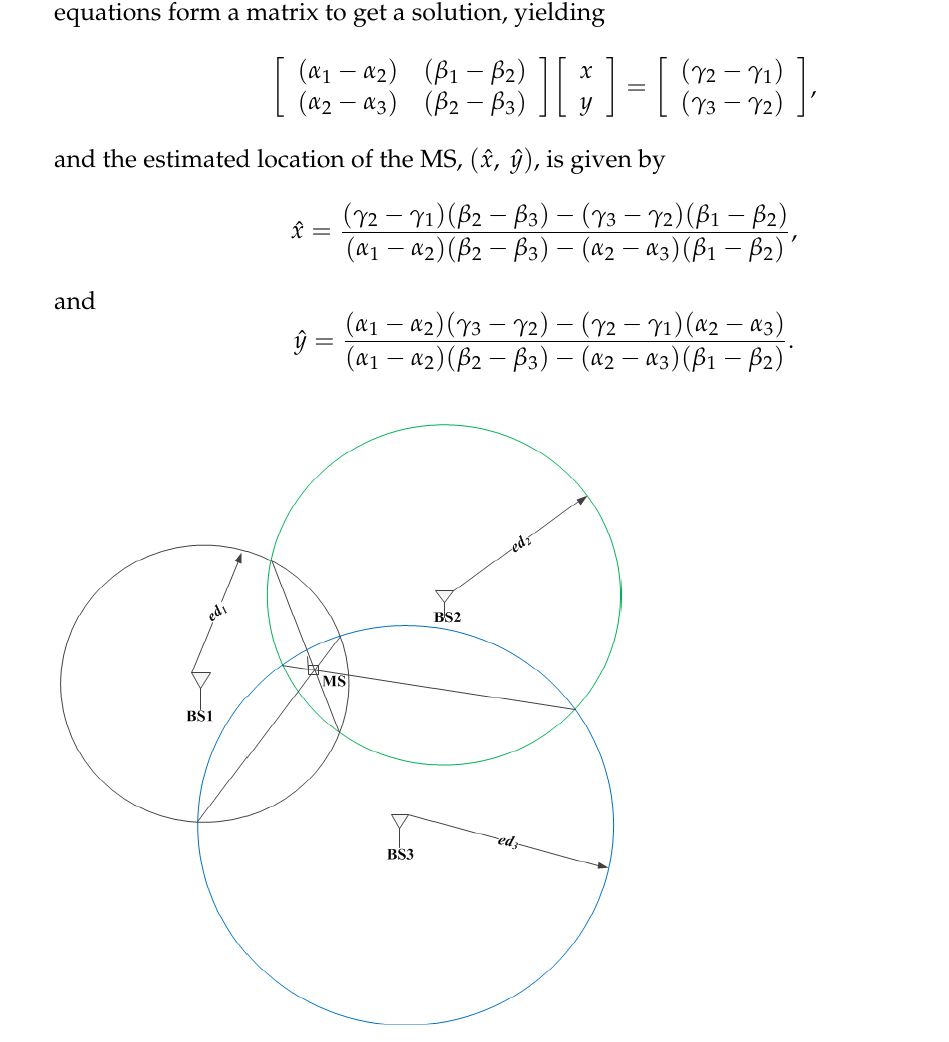
Table 2. Line intersection